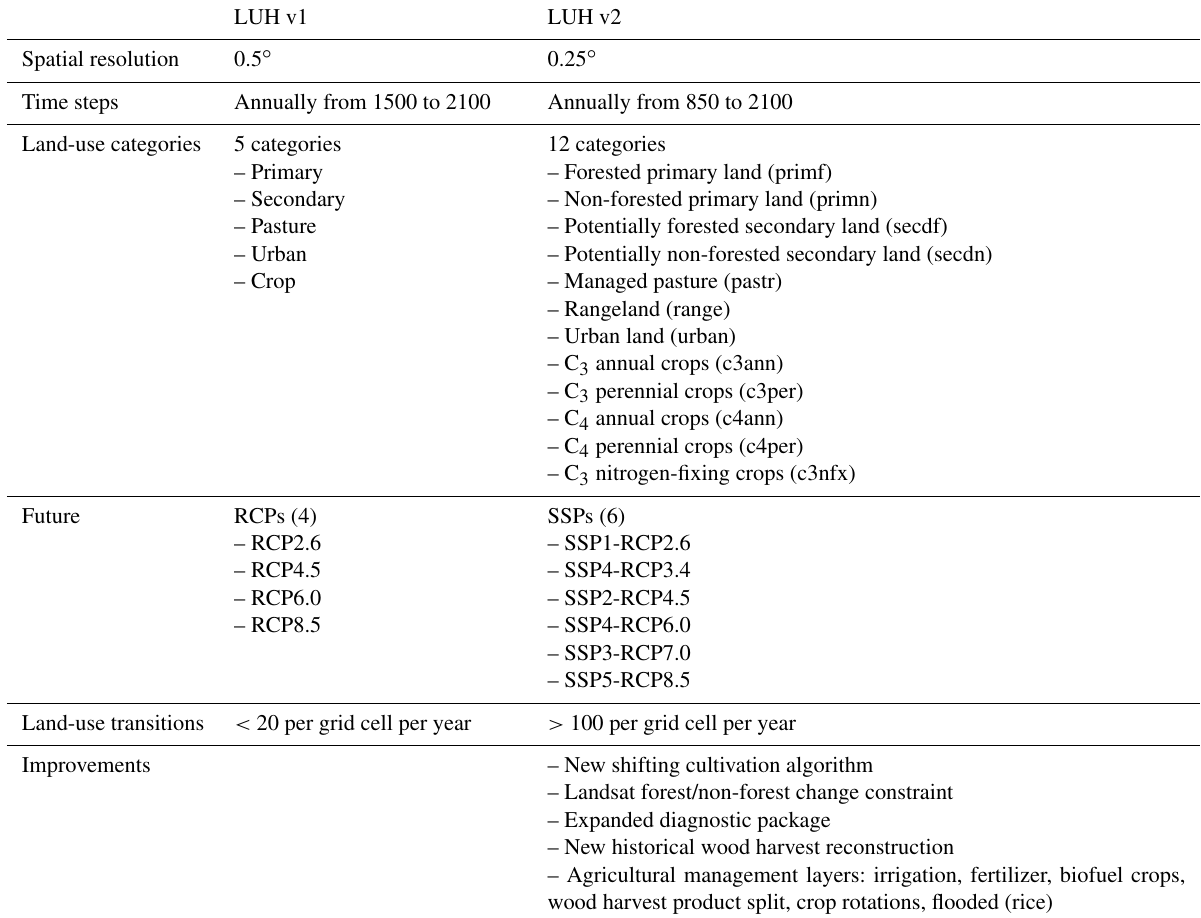
Table 2. Improvements made in the Land Use Harmonization v2 (LUH2) from LUH v1 (sources: Hurtt et al., 2011,